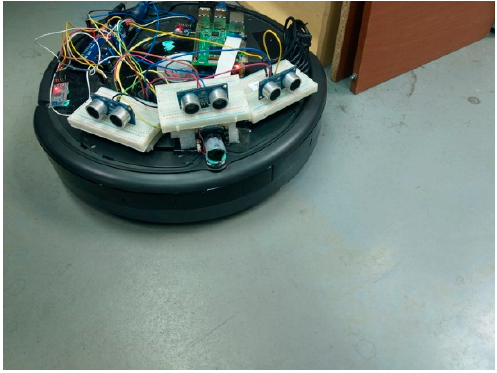
Figure 17. Three ultrasonic sensors installed on the clean robot.